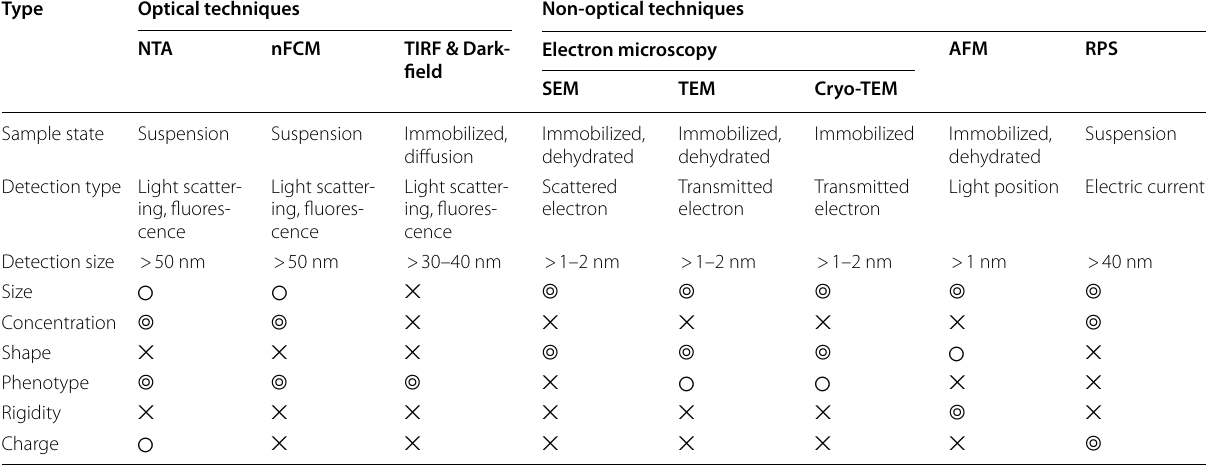
Table 1 Comparison of single EV analysis